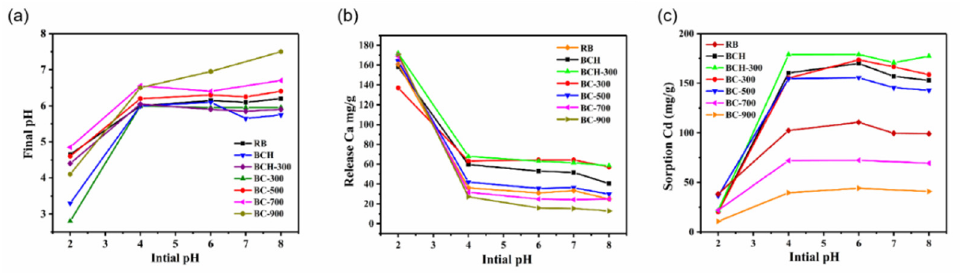
Figure 4. Effect of initial pH on the final pH values ( a ), amount of released Ca 2+ ( b ), and amount of adsorbed Cd 2+ ( c ).